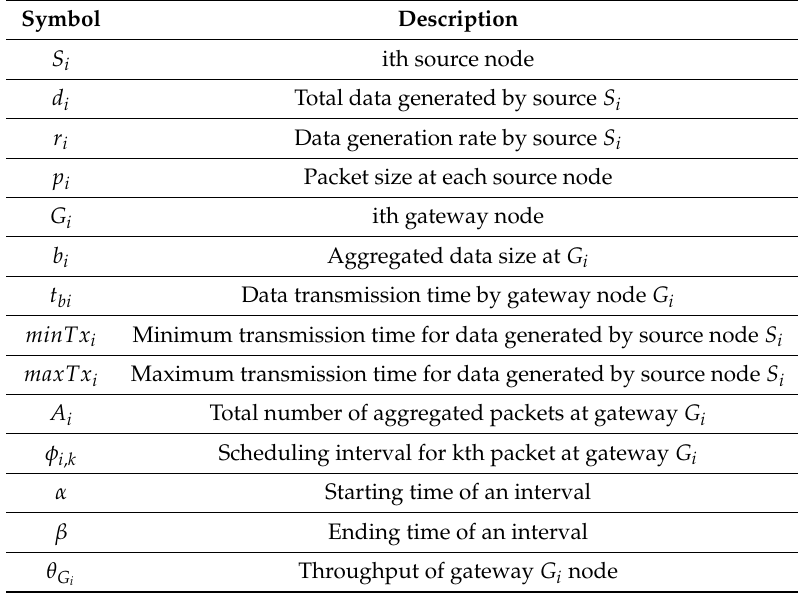
Table 1. Description of the symbols used in the